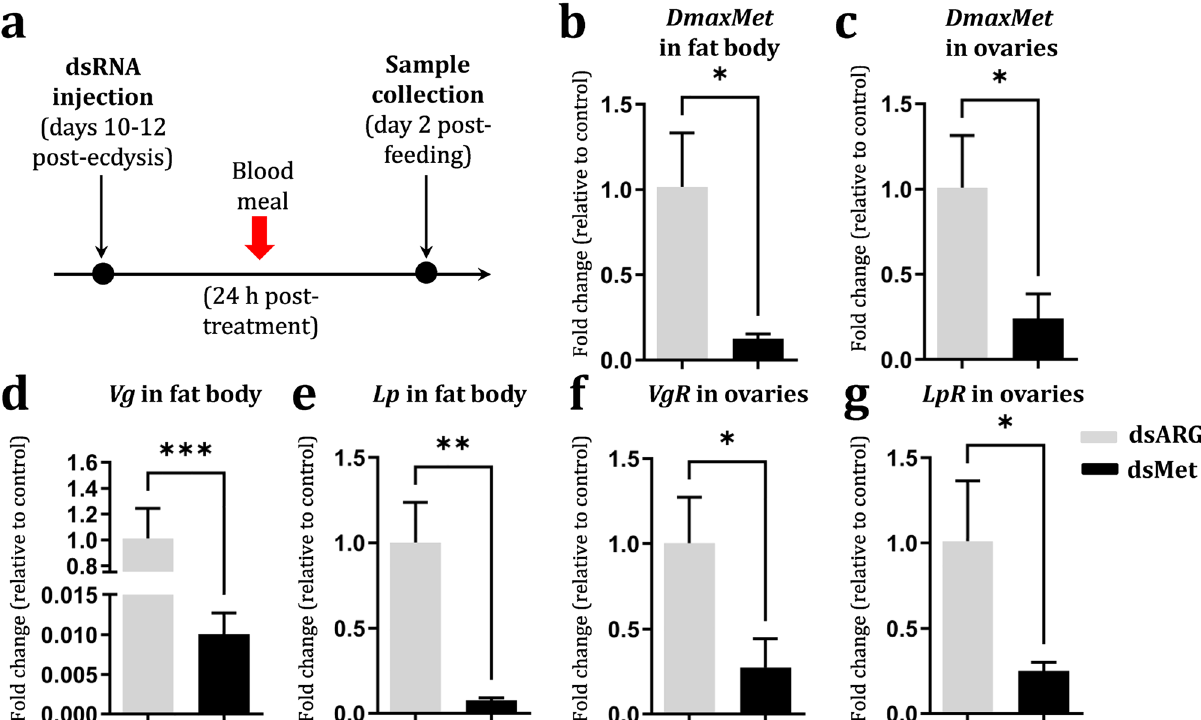
Figure 3. Effect of DmaxMet gene silencing. ( a ) Experimental scheme. ( b – c ) Knockdown efficiency of dsMet treatment in the fat body ( b ) and in ovaries ( c ). ( d – e ) Effect of dsMet and dsARG (control) treatment on Vg ( d ) and Lp ( e ) transcript expression in the fat body. Effect of dsMet and dsARG treatment on VgR ( f ) and LpR ( g ) transcript expression in ovaries. The statistical analyses were performed using Student’s t-test. The results are shown as mean ± SD of three independent experiments and included samples from insects processed individually ( n = 3). * P < 0.05; ** P < 0.01; *** P <